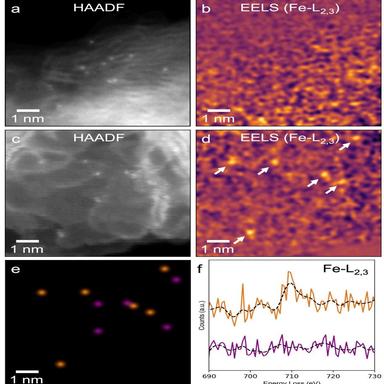
Comparison of conventional and DED STEM-EELS mapping of FeReNC. (a) HAADF image and (b) conventional EELS mapping of the Fe-L2,3 edge, showing no localization of signal above the noise level of the data. (c) HAADF image and (d) DED EELS map of the Fe-L2,3 edge, demonstrating the ability to directly map individual Fe atom positions. (e) These positions, as well as the other metal positions obtained from the HAADF image, can be used to verify (f) the presence and absence of an Fe-L2,3 edge at the atoms identi